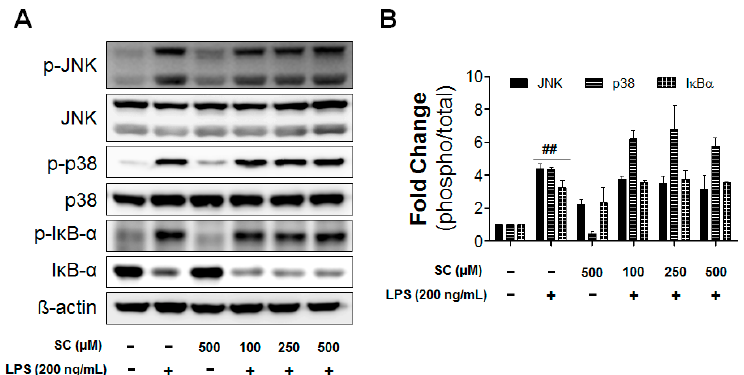
Figure 6. Effect of scoparone on LPS-induced MAPKs and NF- κ B activation in BV-2 microglial cells. The BV-2 microglial cells were seeded at 2.5 × 10 5 cells/mL, and were incubated for 1 h with various concentrations of scoparone 1 h before the stimulation with LPS. The cell lysates were electrophoresed, and the phospho-JNK, JNK, phospho-p38, p38 MAPKs, phospho-I κ B- α , and I κ B- α expressions were detected using a specific antibody ( A ). The quantification data are shown in the right panel ( B ). Data are the mean ± standard error ( n = 3) of three independent experiments. ## p < 0.01, compared with the control